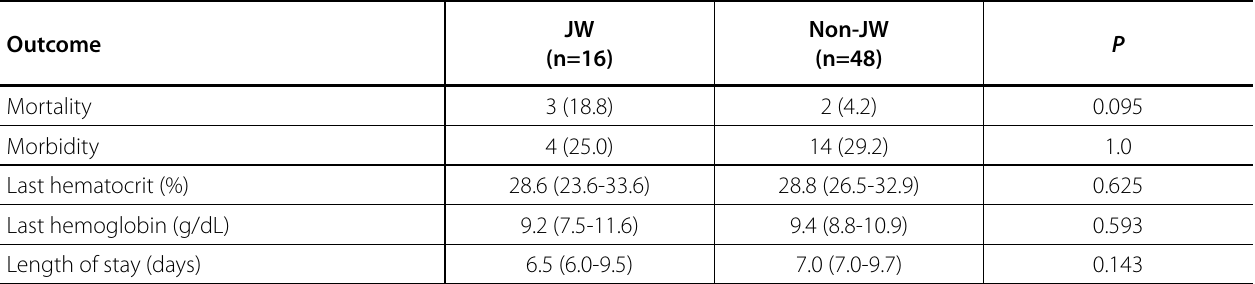
Table 3. Hospital outcomes.